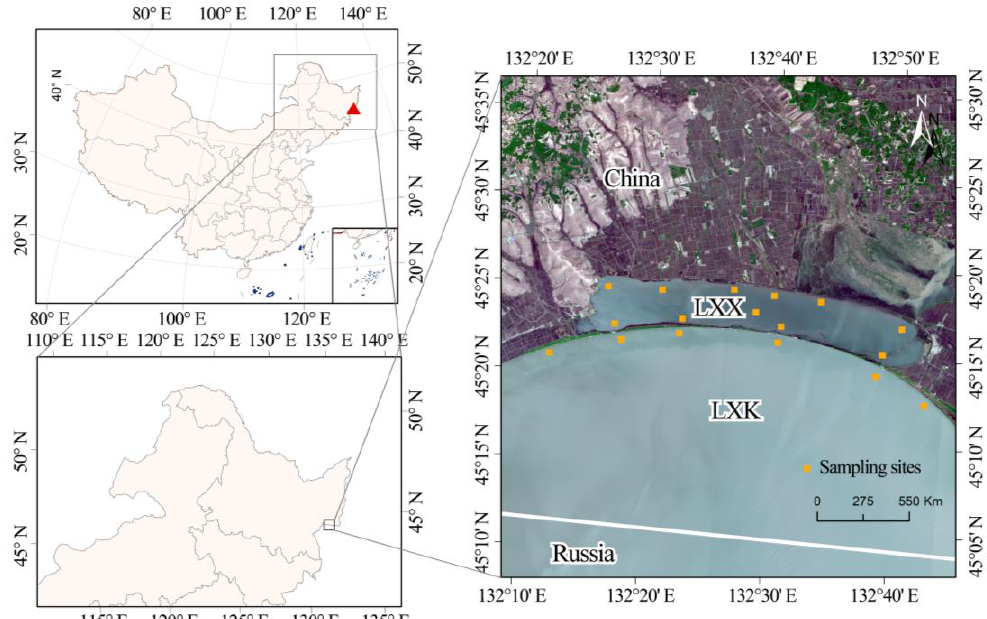
Figure 1. Location of sampling sites in LXK and LXX.